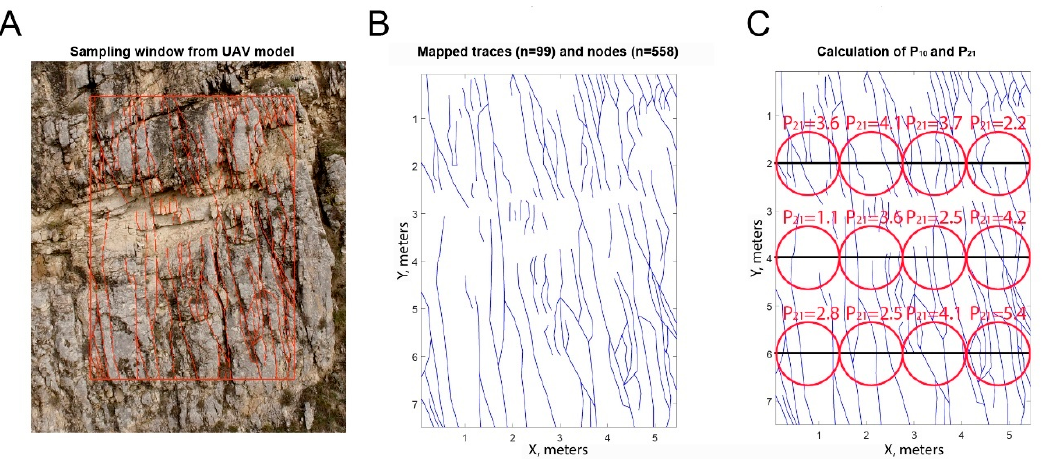
Figure 4. ( A ) Sampling windows from UAV 1. ( B ) Fractures (associated to one joint set) identified in the test sampling windows. ( C ) Calculation of P 21 (within the 16 red circles).